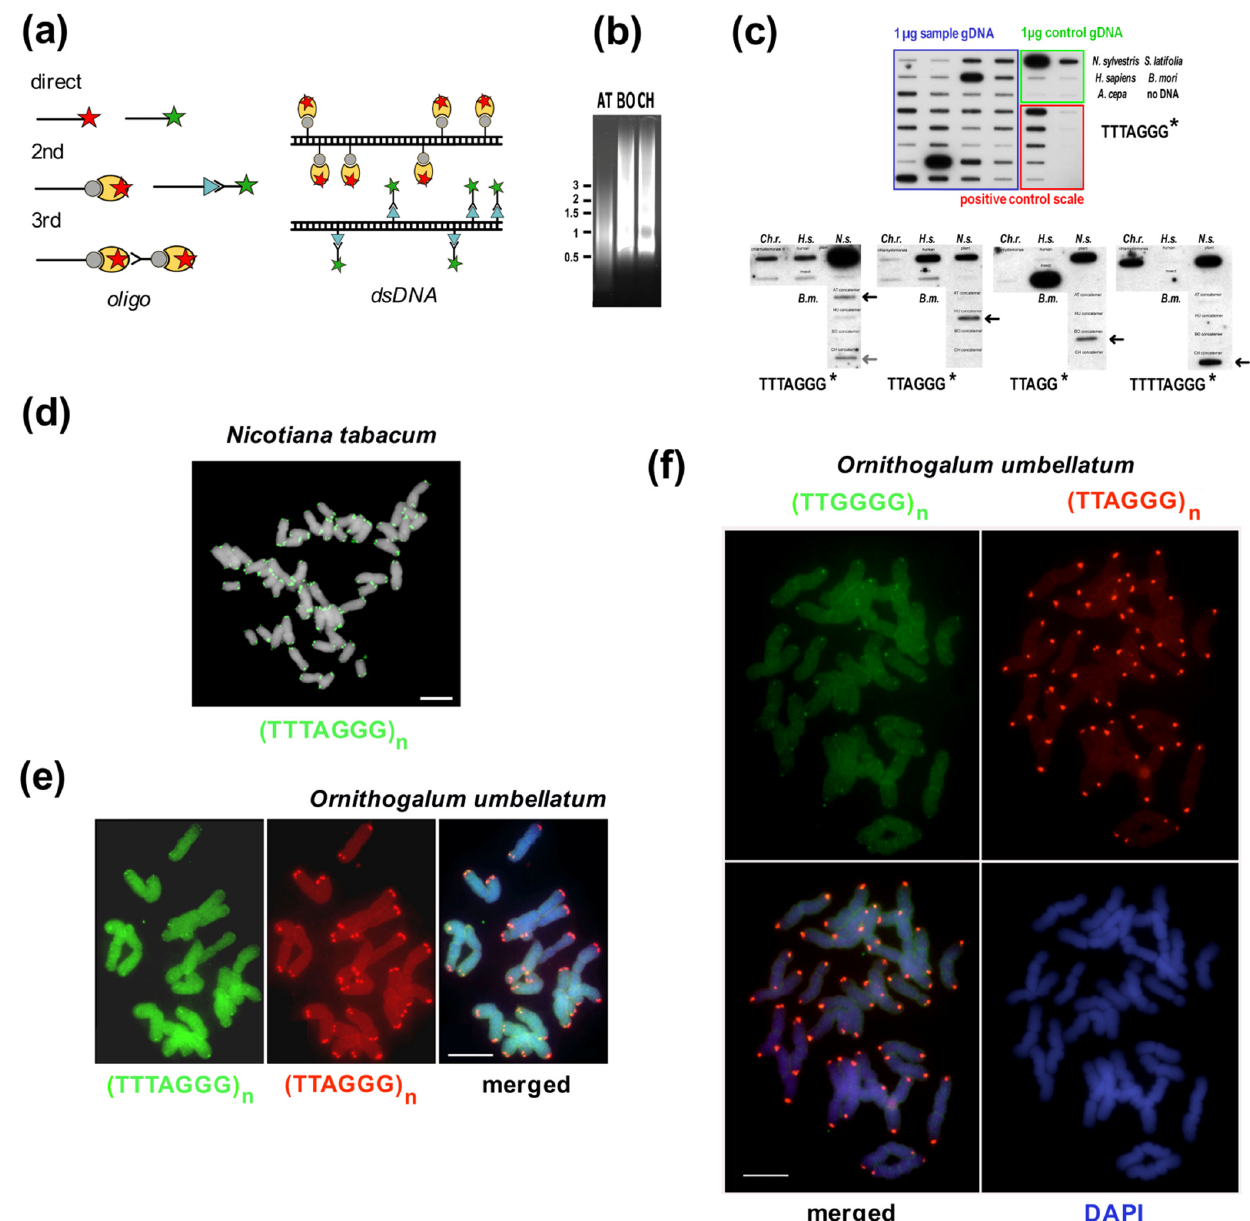
Figure 6. Telomere identification by FISH and slot-blot hybridization. ( a ) Example FISH probes ( top to bottom ), custom synthesized oligonucleotides directly labeled with a fluorophore (asterisk). Biotinylated (circle) oligonucleotides, for secondary detection using streptavidin-bound fluorophore or tertiary detection, e.g., in a sandwich with biotinylated anti-streptavidin antibody and secondary antibody conjugated with a fluorophore. Digoxigenin-labeled (triangle) oligonucleotides are visualized by an anti-digoxigenin antibodies conjugated with a fluorophore. dsDNA probes for FISH and other hybridization techniques are often labeled in PCR reactions or by nick translation using biotin/digoxigenin modified nucleotides incorporated into products. ( b ) Template-free PCR produces a typical smear of products generated by self-annealing of corresponding G- and C- telomeric oligonucleotides (AT, Arabidopsis -type TTTAGGG/CCCTAAA; BO, Bombyx -type TTAGG/CCTAA; CH, Chlamydomonas -type TTTTAGGG/CCCTAAAA, [198,322] ) and amplification by Taq DNA polymerase. Concatemers can be labeled radioactively for Southern hybridization or can have modified nucleotides incorporated as for FISH. ( c ) Slot-blot hybridization screening for telomere sequence signals using radioactively (*) labeled oligonucleotide probes. ( Upper panel) gDNA samples of interest (24 species, blue frame, modified from [139]) and controls